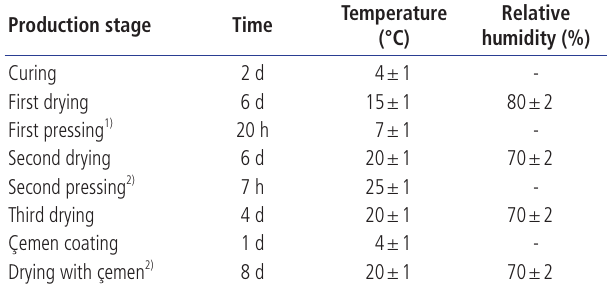
Table 1. The stages of pastırma